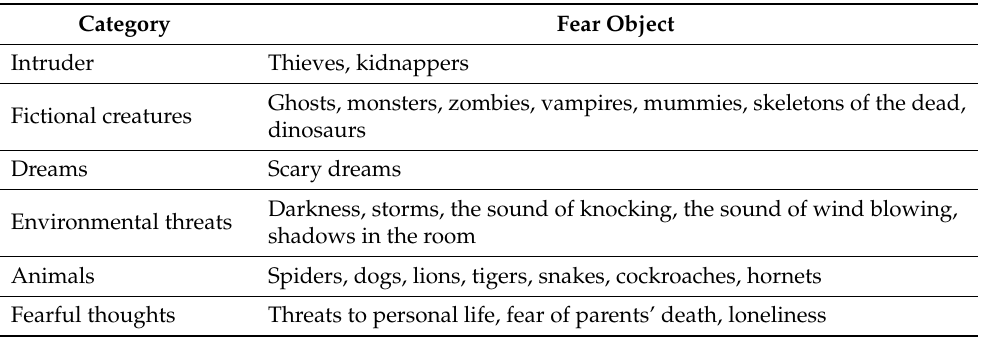
Table 3. Children’s nighttime fear